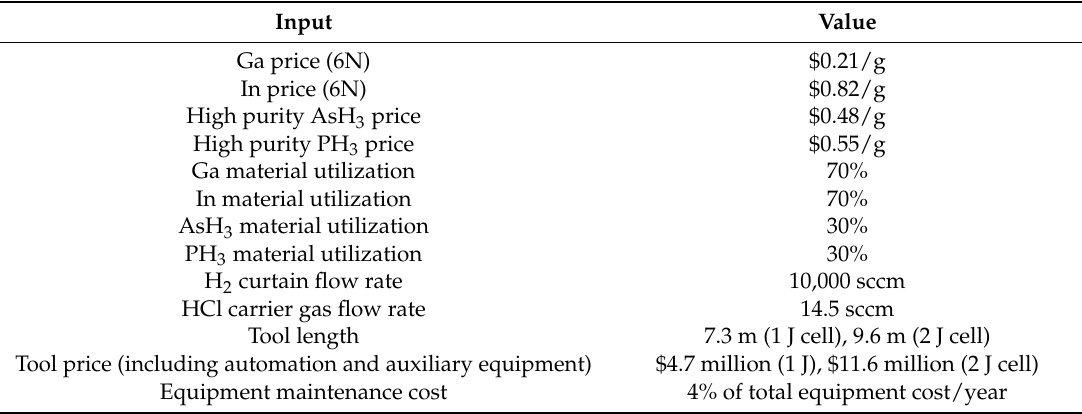
Table A1. Key Input Assumptions for the HVPE Deposition Cost